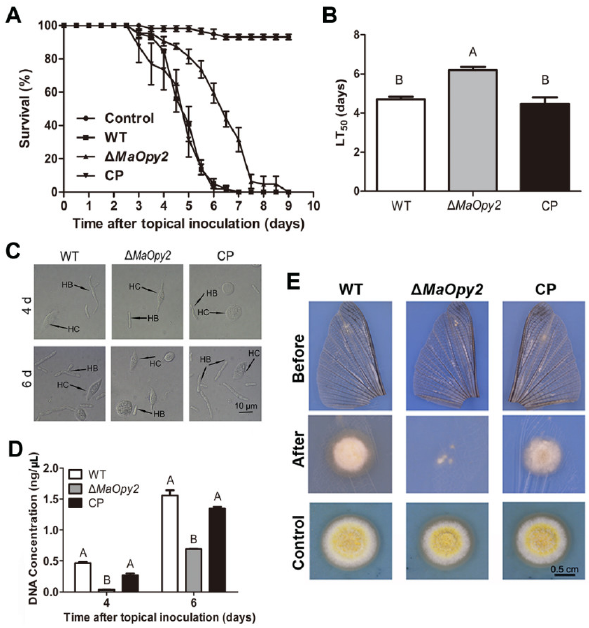
Figure 4. Topical inoculation assays. ( A ) Survivals of locusts by topical inoculation. ( B ) LT 50 s of fungal strains for topical inoculation. ( C ) Fungal growth inside insect hemolymph by topical inoculation for 4 d or 6 d. ( D ) Quantification of fungal gDNA through topical inoculation. ( E ) Penetration assays. A & B presented the significant difference at p <